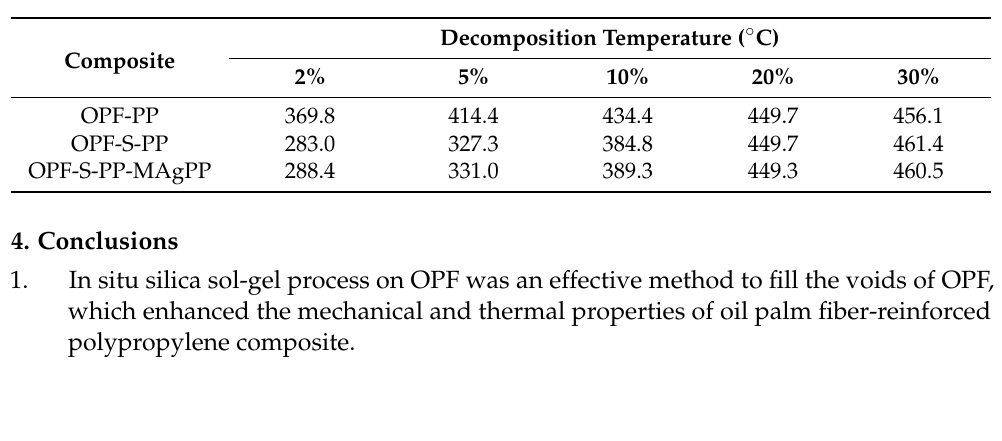
Figure 9. Thermogravimetric curves of OPF-PP, OPF-S-PP, and OPF-S-PP-MAgPP composites. Table 6. Decomposition temperature of composites at different weight losses from thermogravimetric analysis.